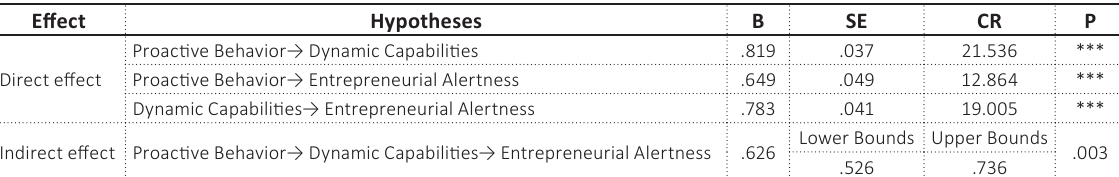
Table 4. Path coefficients, SE, CR, and P-values